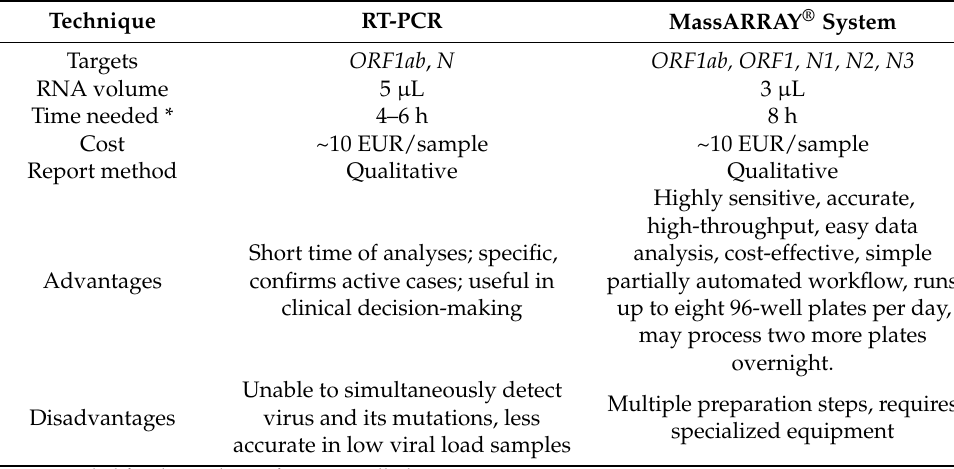
Table 4. Comparison of both methods for the detection of